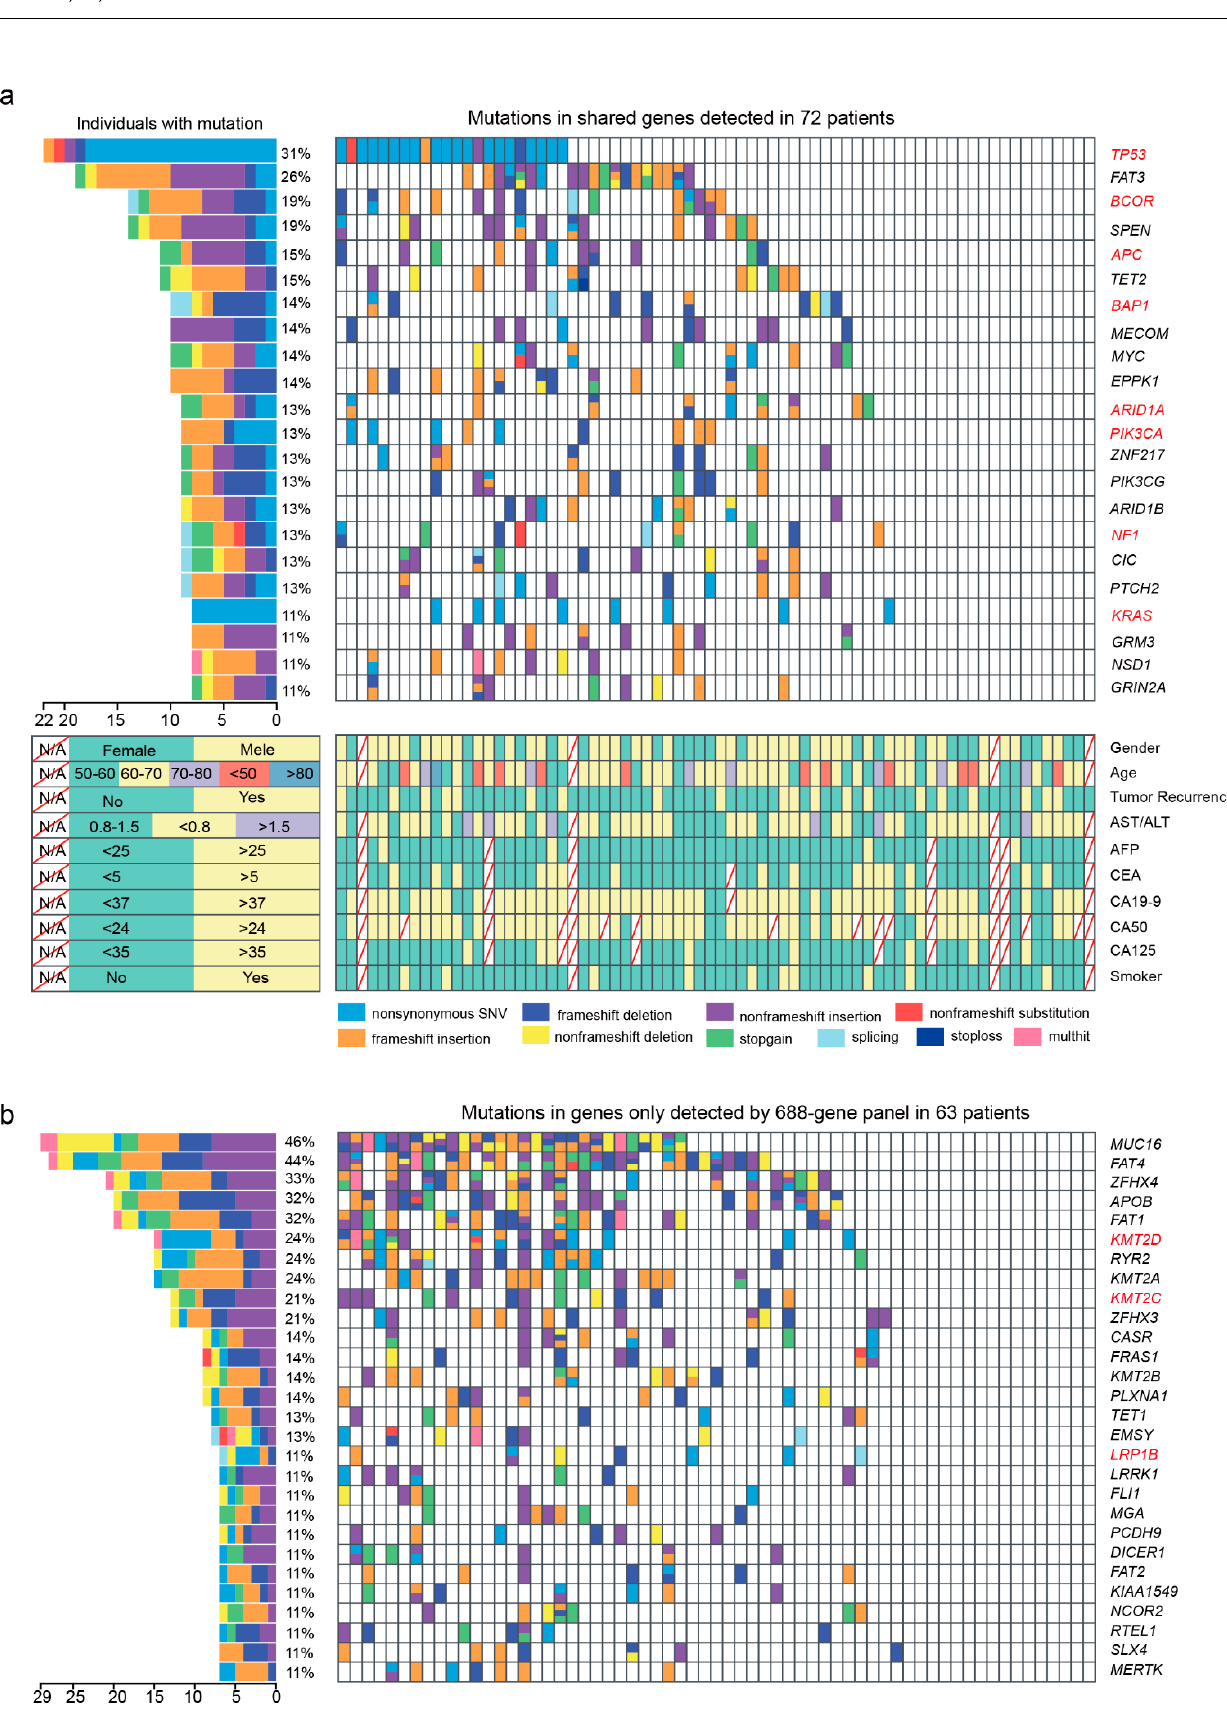
Figure 2. The landscape of frequently mutated genes of CCA. ( a ) Significantly mutated genes both detected by 508– and 688–gene panels in 72 patients. Left, the percentages of patients with mutations. Right, targeted genes are ranked based on the mutation frequency. Red letters indicate driver